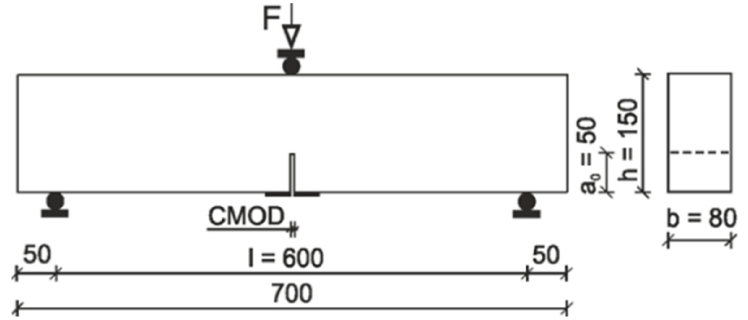
Figure 6. Geometry of notched beam specimens under center-point loading arrangement.